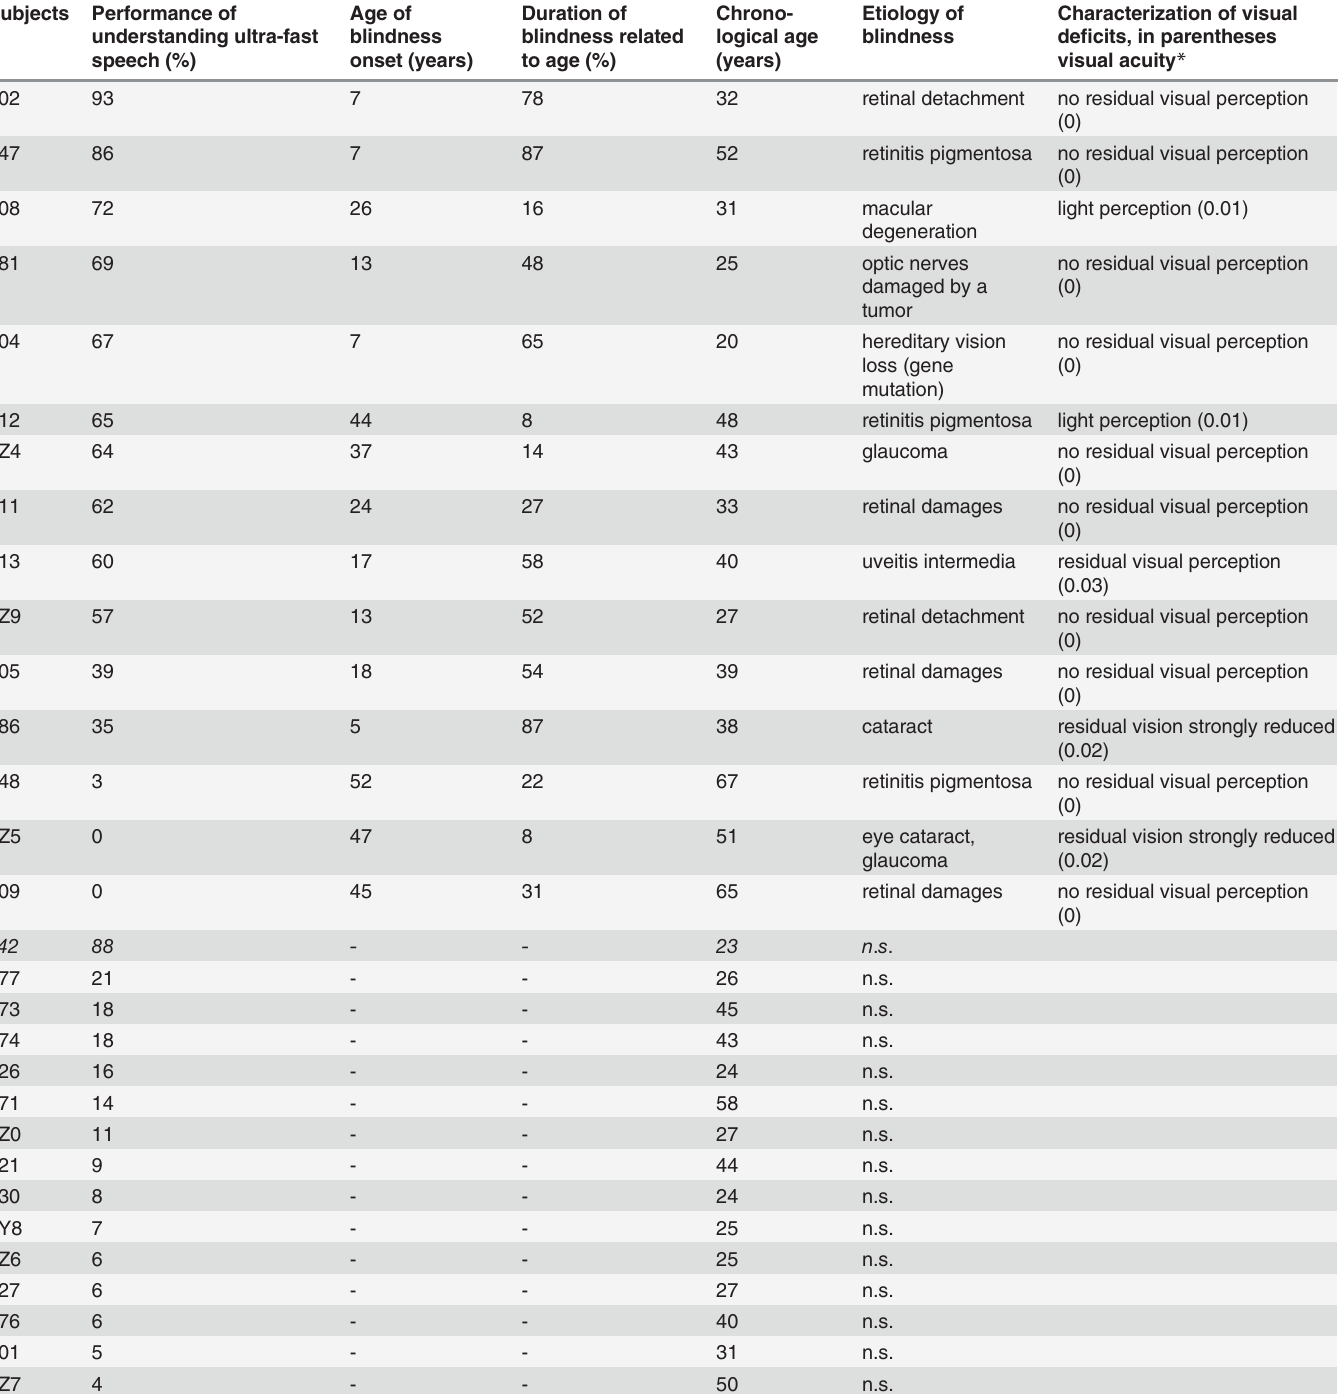
Table 1. Clinical and behavioral data of the vision-impaired and normally sighted